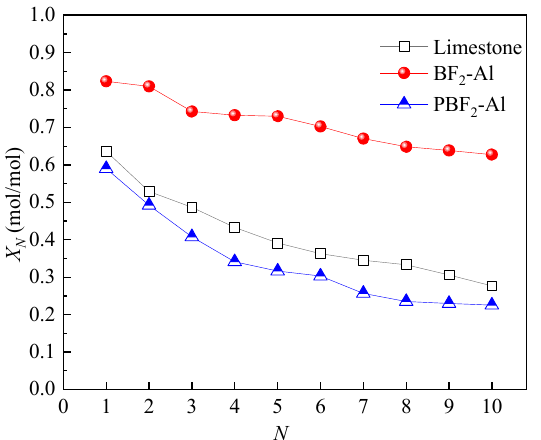
Figure 4. Effect of pyrolysis on cyclic energy storage performance of templated CaO-based materials with doped Al 2 O 3 .